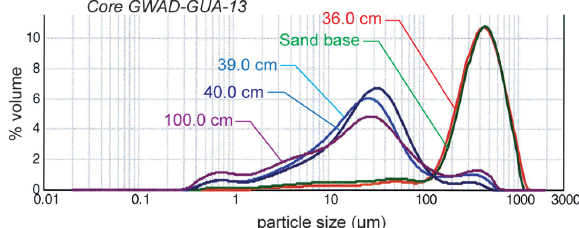
Fig. 9. Compared grain-size distributions of upper homogenite and hemipelagic sediments (MALVERN TM laser microgranulome- ter